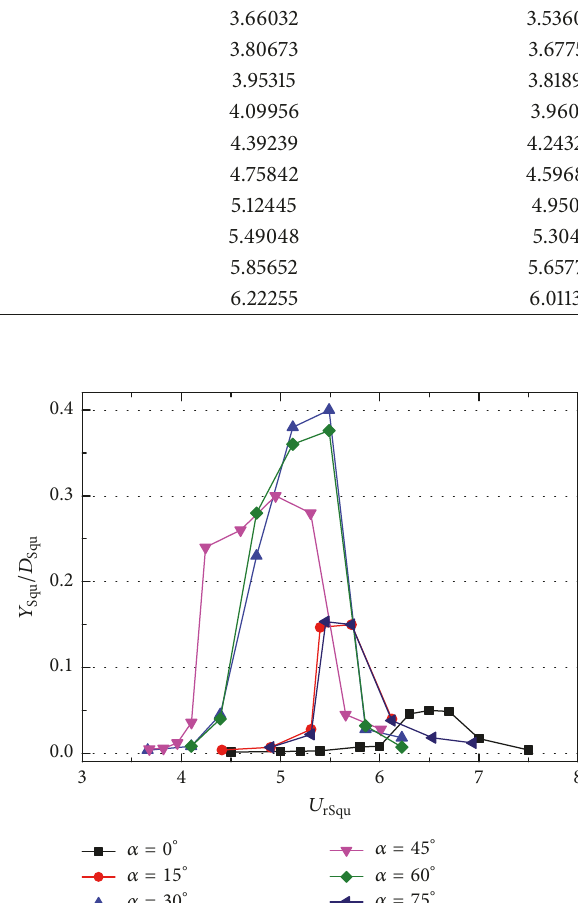
Figure 4: Dimensionless vibration amplitude of square column VIVPEH under different attack angles and different flow velocities.